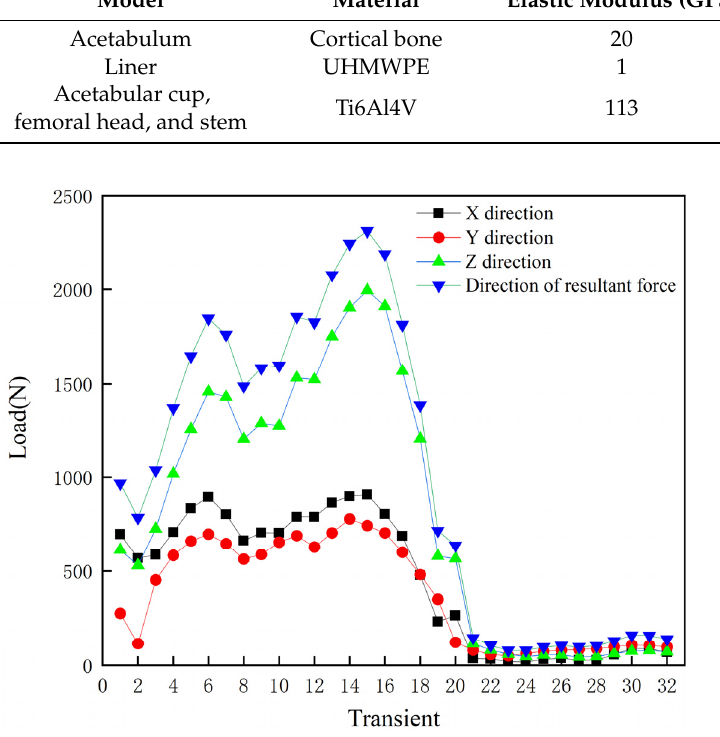
Figure 5. Joint loads at 32 transients of the gait cycle.